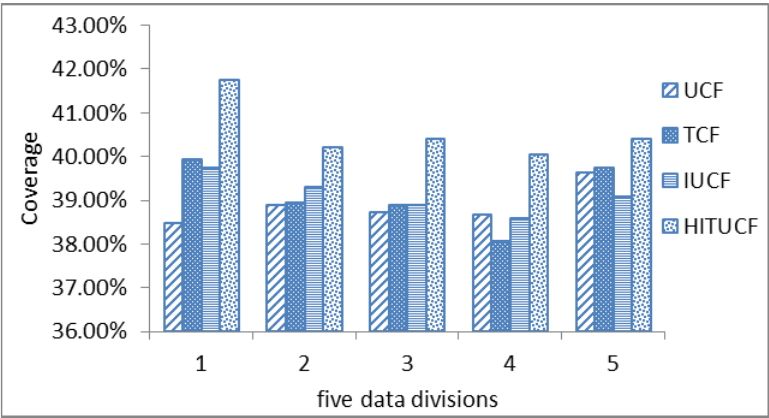
Figure 15. Coverage of five data divisions.